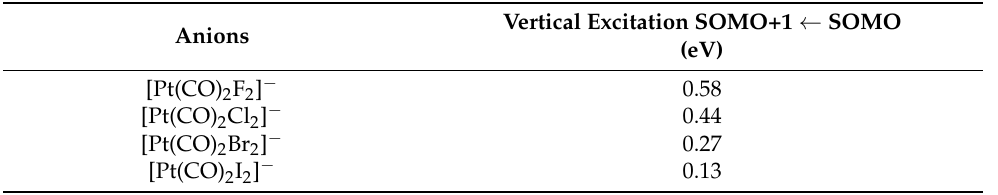
Table 1. Calculated vertical excitation energy from the anionic ground state to the first anionic excited at the TDDFT wB97X-D3/ma-def2-TZVP level of theory. Anions Vertical Excitation SOMO+1 ← SOMO (eV)